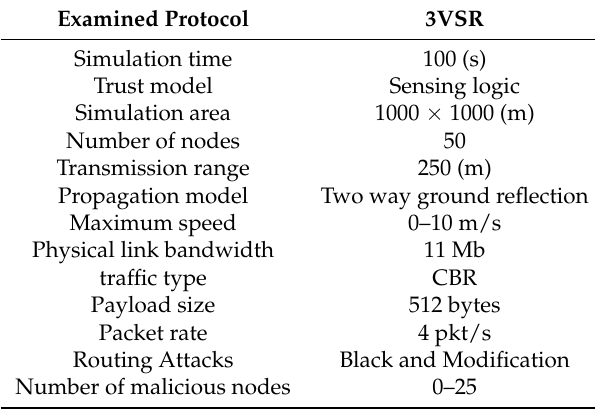
Table 2. Simulation